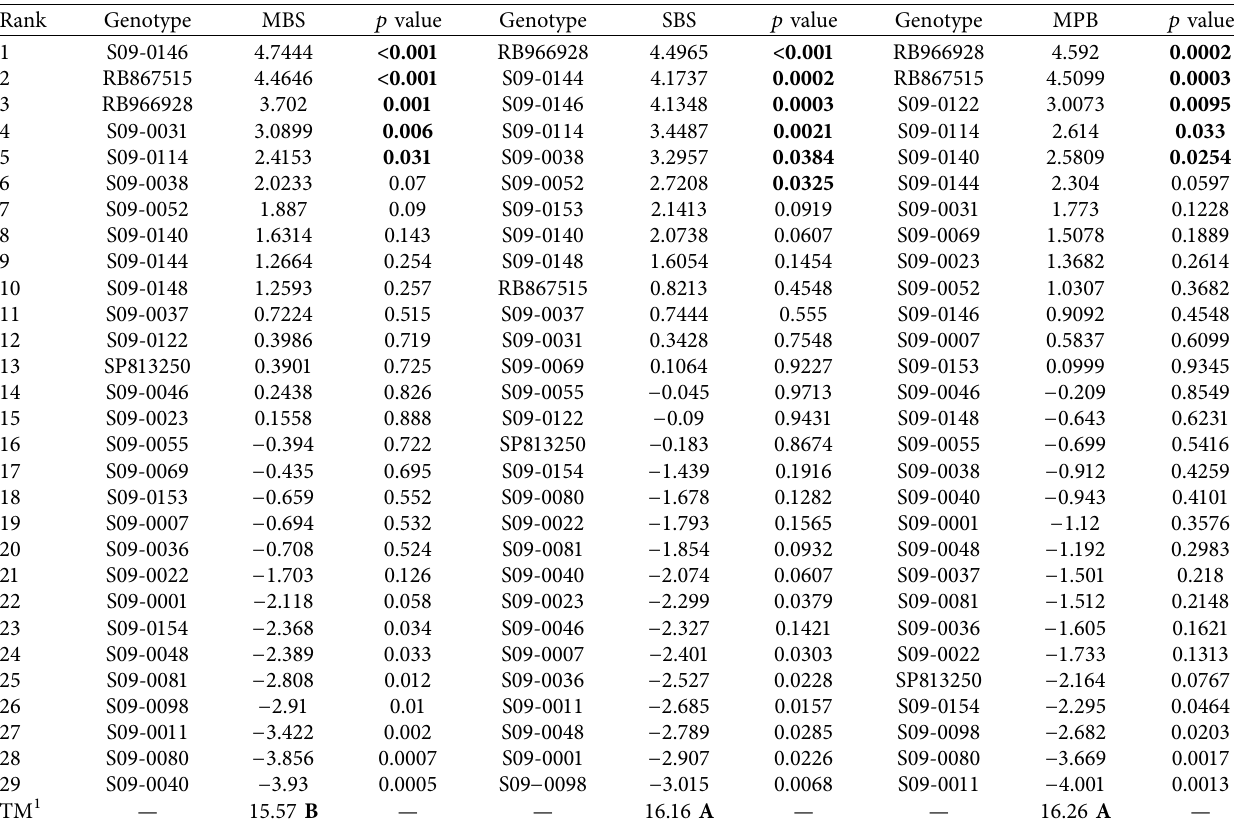
Table 5: Predicted genotypic differences (PGD) for TPH_TBH across 29 genotypes (mean plant cane TPH and 1st ratoon TBH) and three planting material types (MBS, SBS, or